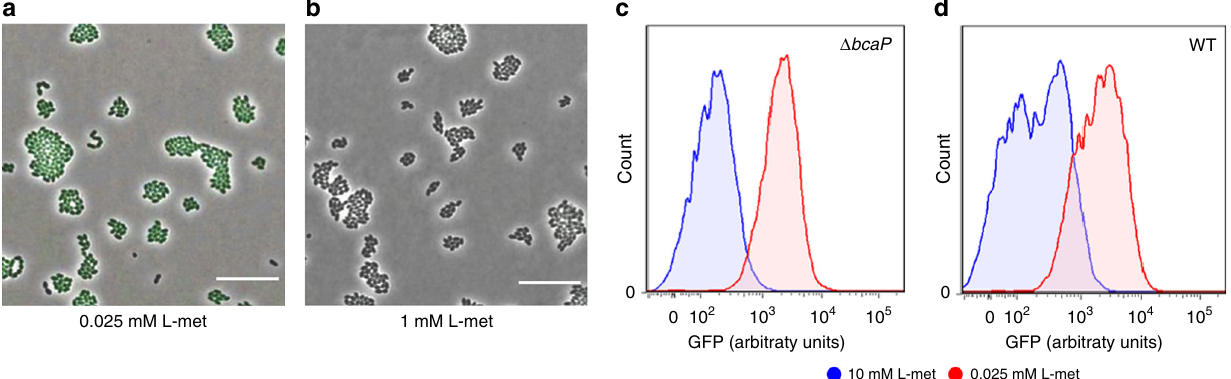
Fig. 4 The low-af fi nity methionine transporter, BcaP, supports the growth of the GFP − cells. a , b Snapshots of single-cell fl uorescence microscopy in the L. lactis Δ bcaP Pmet-gfp strain. a cells grown at low methionine concentrations (0.025 mM) and b at high methionine concentrations (1 mM). Scale bars, 15 µ m. c , d Single-cell fl uorescence measurements by fl ow cytometry in the bcaP deletion mutant strain ( c ; L. lactis Δ bcaP Pmet-gfp ) and wild-type strain ( d ; L. lactis Pmet-gfp ), grown in CMD with low and high methionine concentrations (0.025 and 1 mM, in red and blue respectively), 10,000 ungated events recorded are shown. Source data are provided as a Source Data fi